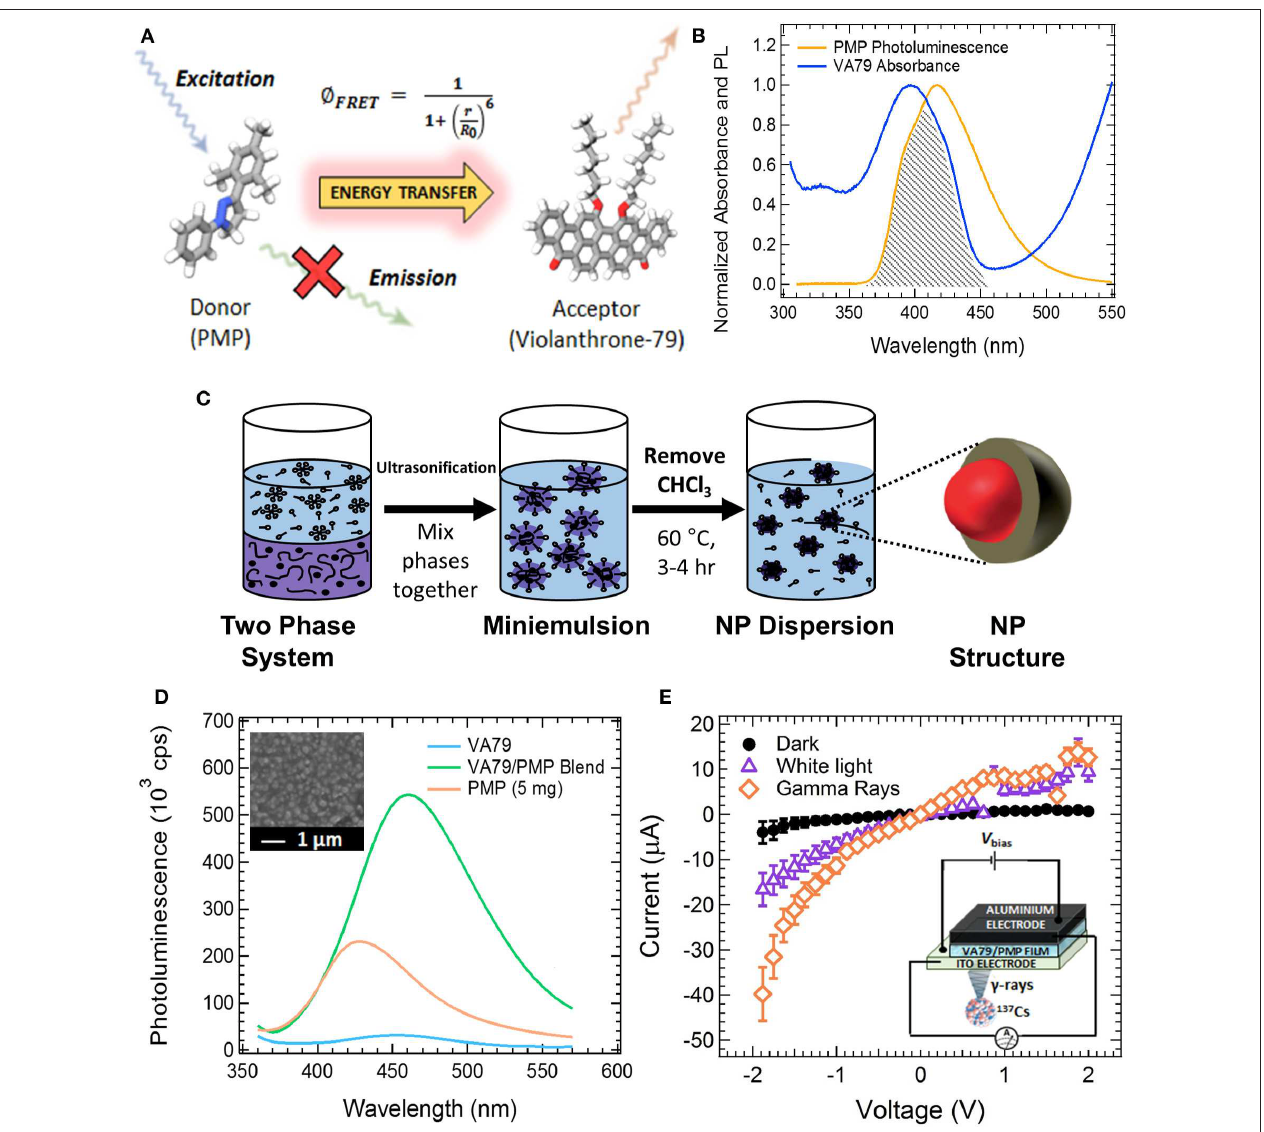
FIGURE 5 | A blended two-phase organic semiconductor (OSC) nanostructured radiation sensor. (A) Schematic illustration of Förster resonance energy transfer from the 1-phenyl-3-mesityl-2-pyrazoline (PMP) scintillator (donor) to the violanthrone-79 (VA79) polymer (acceptor). (B) Normalized spectra comparing the photoluminescence output of PMP with the absorbance spectrum of VA79. (C) A schematic illustration showing the process of blended OSC nanoparticle formation using the miniemulsion method. (D) Steady-state photoluminescence measured at an excitation wavelength of 315nm for solid films prepared with pure VA79, pure PMP, and a VA79/PMP blend. The large growth in the output of VA79 in the presence of PMP indicates efficient Förster resonance energy transfer. The inset shows an SEM image of the nanoparticulate film structure. (E) Device current plotted as a function of bias voltage for sensors fabricated with a 50% mixture of VA79 and PMP. Data are shown for sensors in the dark (black circles), under illumination from a Xenon lamp (purple triangles) and under irradiation from a 137 Cs source (orange squares). The inset shows the radiation sensor device